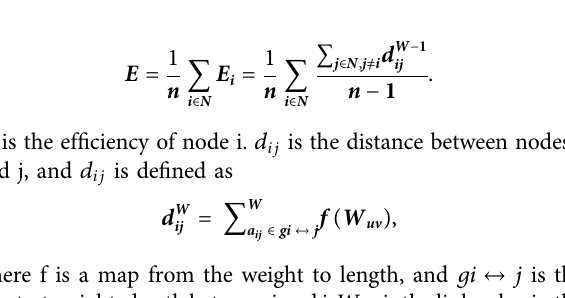
Frontiers in Physiology |